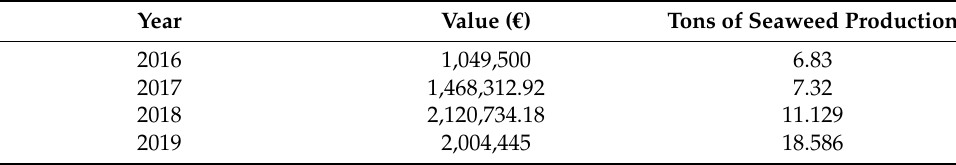
Table 1. Value of seaweed production in Spain. Year Value ( €